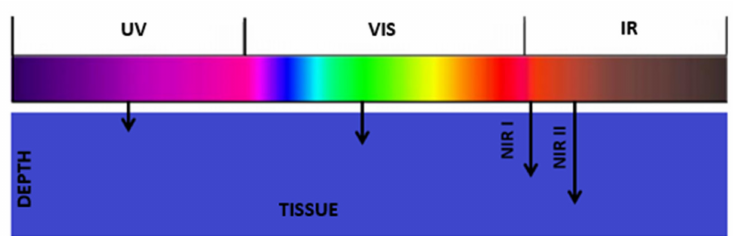
Figure 7. Diagram of tissue penetration by radiation of unequal